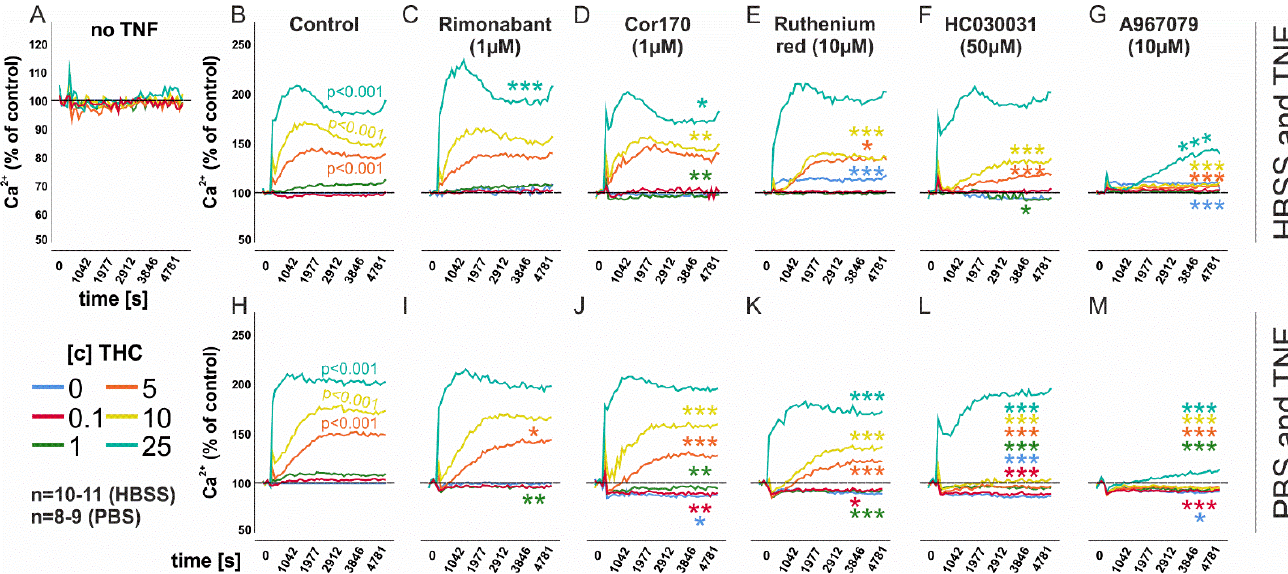
Figure 2. Mean intracellular calcium level changes in RASF in response to THC. ( A ) Intracellular calcium mobilization without TNF pre–stimulation. ( B , C ) Intracellular calcium level regulated by THC (0.1 − 25 µM) with TNF (10 ng/mL) pre–stimulation for 72 h and extracellular calcium (HBSS; ( B – G )) or without calcium (PBS; ( H – M )). *** p < 0.001, ** p < 0.01, * p < 0.05 for differences between antagonist treatment and control (THC only). ( B , H ) Comparisons of different THC concentrations versus control (no THC). Significant values are given in the graph. ANOVA with Bonferroni post hoc test was used for all comparisons. Rimonanbant, CB 1 inverse agonist; COR170, CB 2 inverse agonist; A967079, TRPA1 antagonist; HC-030031, TRPA1 antagonist; RR = Ruthenium Red, general TRP inhibitor.